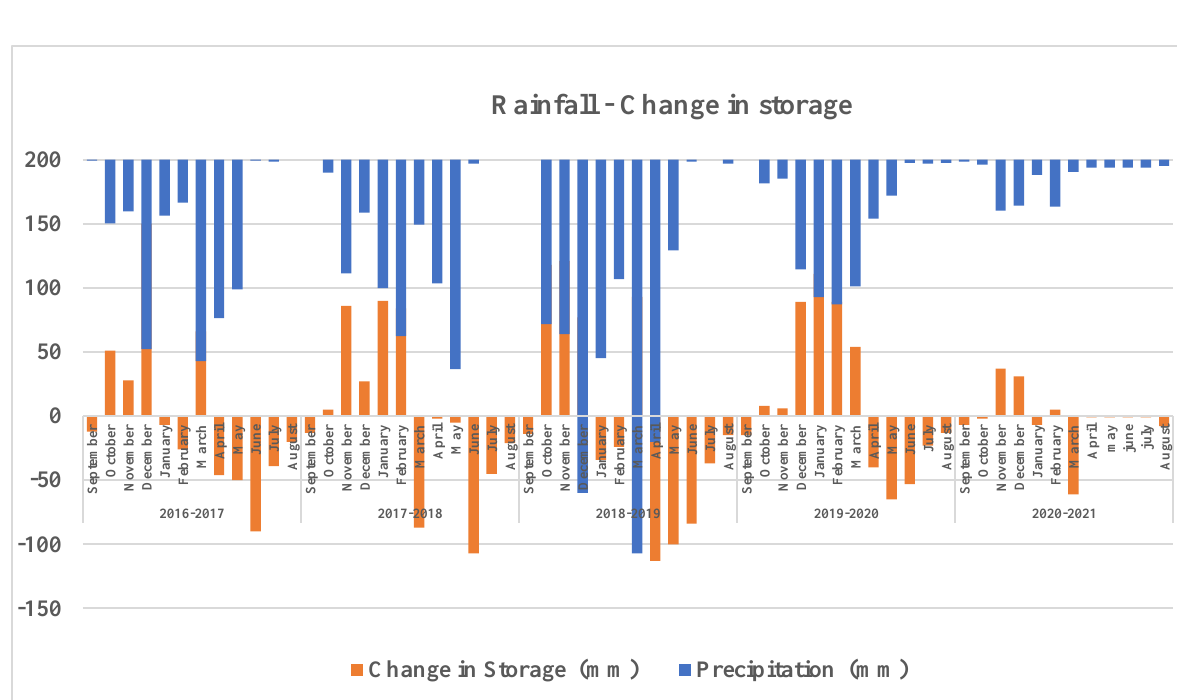
Table 2. Show the annual average of water balance parameters of Duhok dam basin during